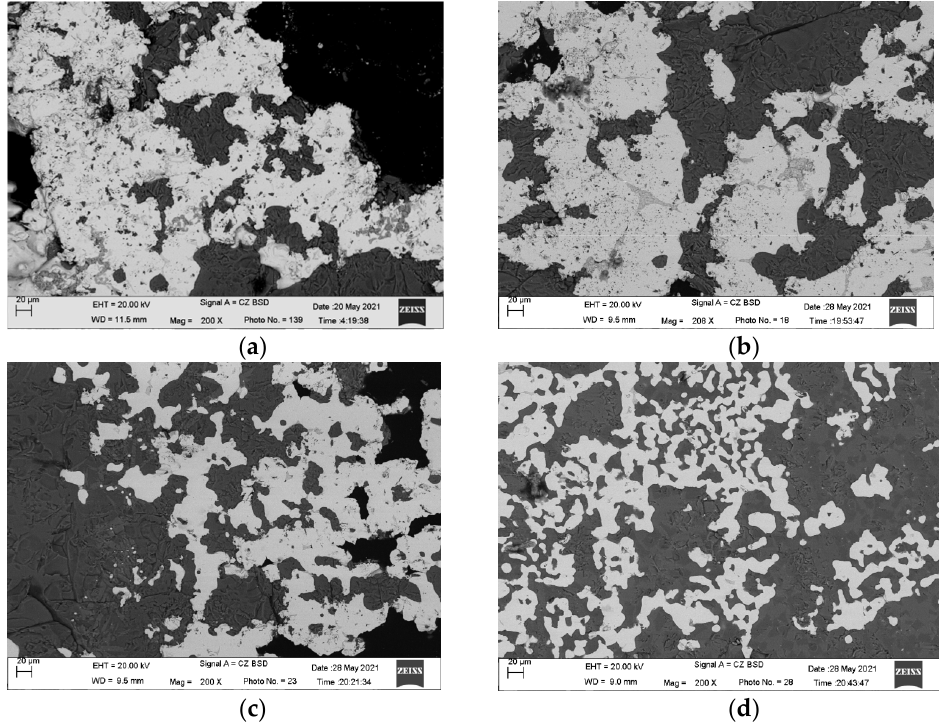
Figure 8. SEM images of roasted products under different CaO dosage. ( a ) 0 wt% CaO; ( b ) 5 wt% CaO; ( c ) 10 wt% CaO; ( d ) 15 wt% CaO. Table 5. Chemical composition of points indicated in Figure 9